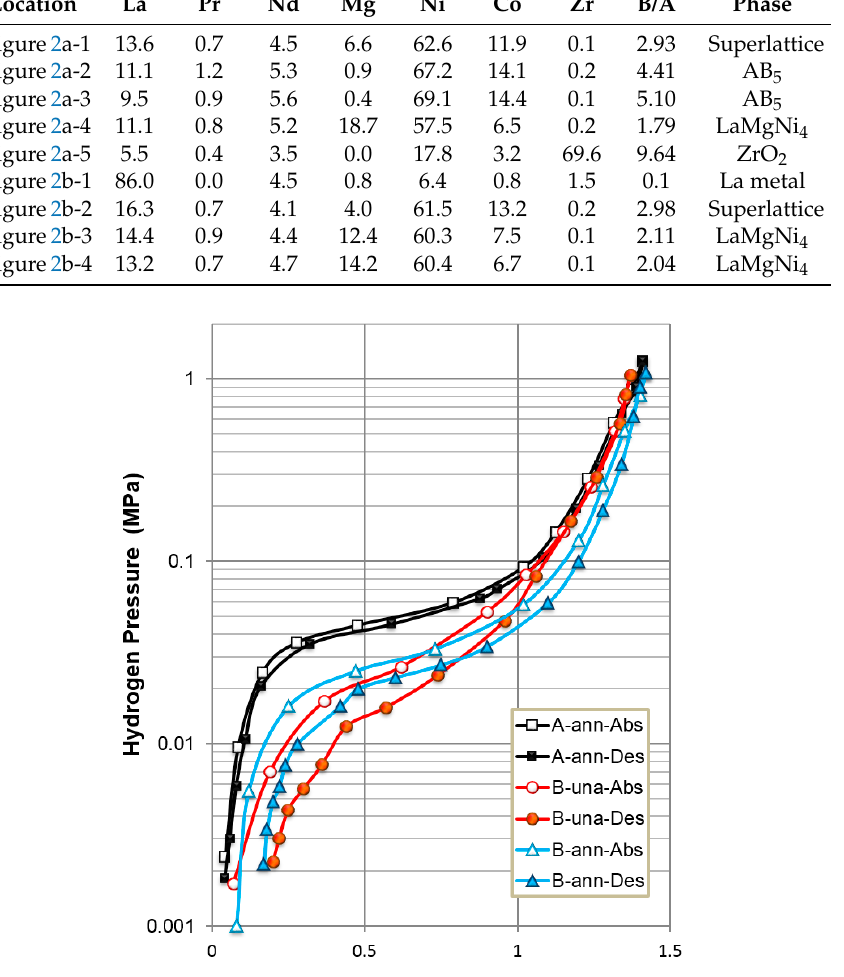
Table 2. Energy-dispersive spectroscopy (EDS) results from selected spots in Figure 2. All numbers are percentages.